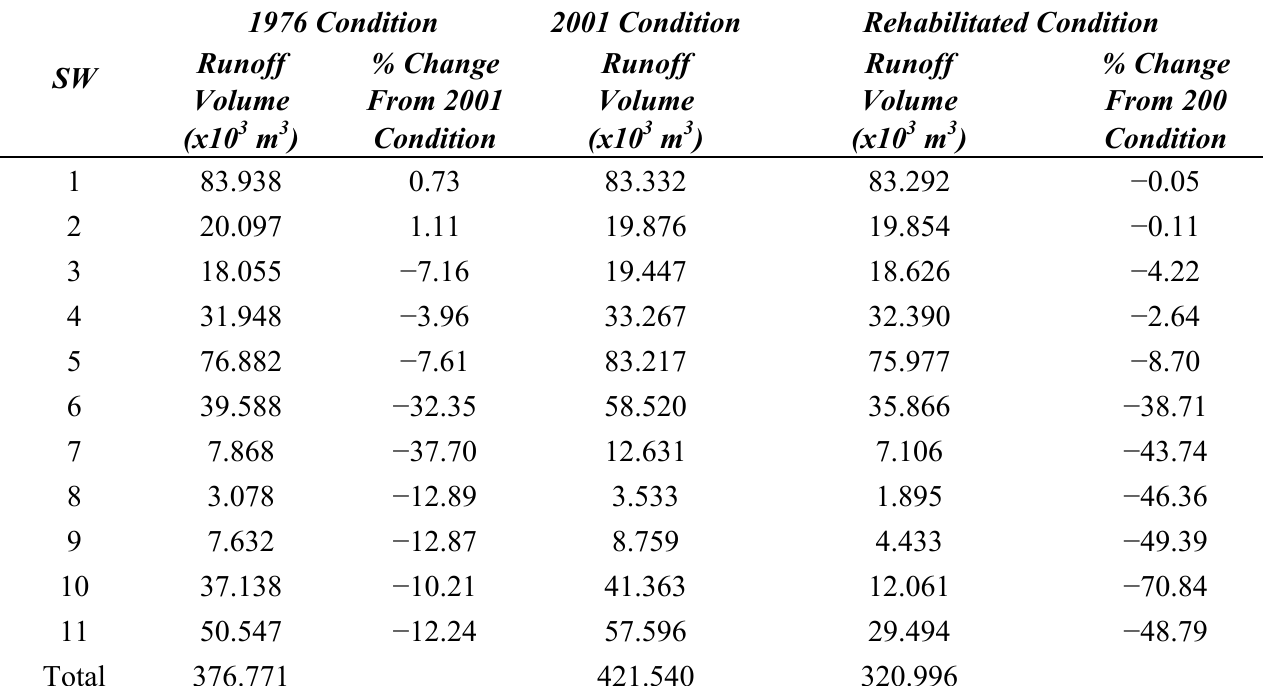
Table 5. Sub-watershed (SW) accumulated runoff volumes for the three land-cover scenarios simulated by the model (25–27 June 2007